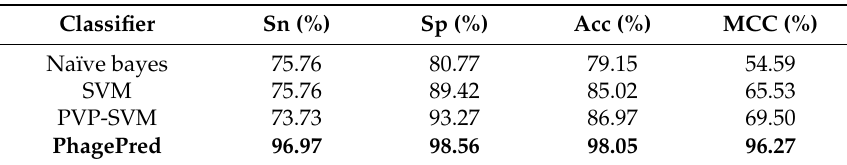
Table 2. Comparison of state-of-the-art methods with